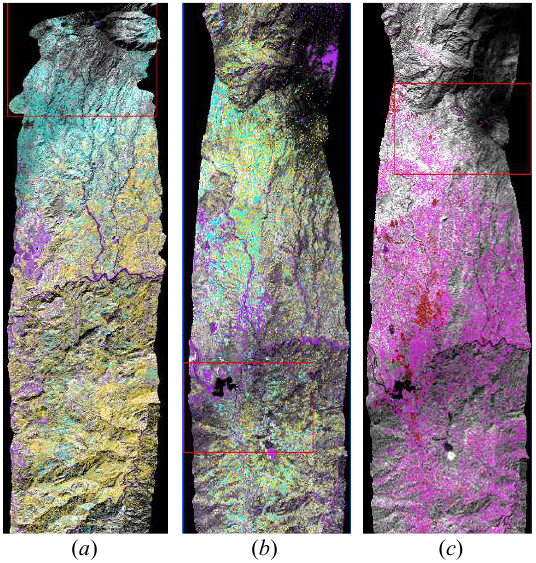
Figure 2. Colour composite of abundance for minerals (Alu- cyan, Illi-yelow, Kaol-purpel, Kaol+Sme-purpel2, Mont- maroon) from HyMAP image ( a ), from MASTER image ( b ), and thermal index THI (red-violet) between 10.16 m m and 12.21 m m from MASTER image ( c